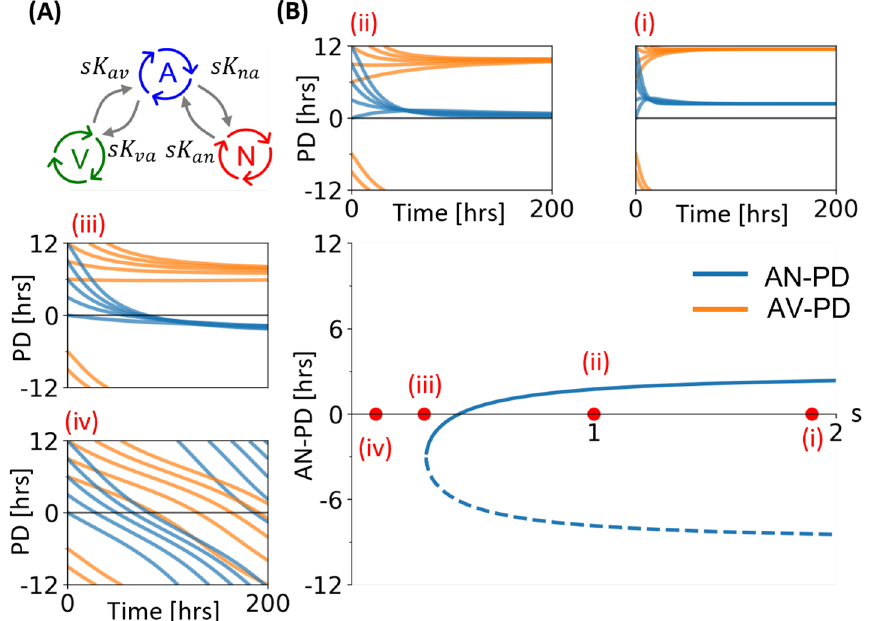
Figure 3. Simulated PD dynamics change as the global coupling parameter decreases. ( A ) The structure of the AP-NTS-4Vep oscillator network with the AP at the center. ( B ) Bifurcation diagram showing how the steady state θ ∗ an changes as the global coupling strength changes. Solid lines are stable solutions and dotted lines are unstable solutions. Inserts (i-iv) show the AN-PD (blue) and AV-PD (orange) dynamics for different values of global coupling, s . Parameters for all the simulations are as given in Table 1, the only difference between simulations being the chosen initial